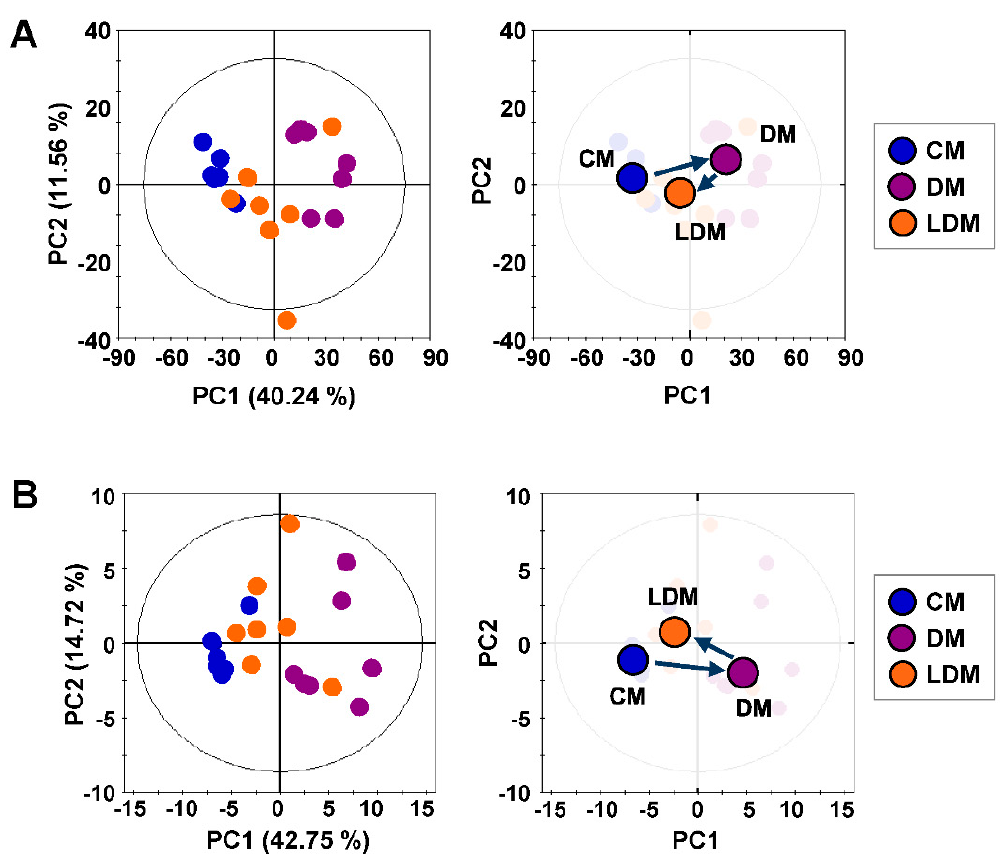
Figure 1. PCA score plots of metabolic profiles of mouse urine. The PCA score plot and trajectory analysis of the PCA score plot ( A ) of global metabolic profiles show perturbation of metabolic patterns in CM (blue dots, n = 6), DM (violet dots, n = 7), and LDM (orange dots, n = 7). The PCA score plot and trajectory analysis of the PCA score plot ( B ) of targeted metabolic profiles were similar to the global metabolic profiles. Circles represent medians of each group. PCA, principal component analysis; CM, control mice; DM, STZ-induced diabetic mice; LDM, losartan-treated diabetic mice. For the targeted metabolite analysis among CM, DM, and LDM, we identified 68 urinary metabolites in the NMR spectra. The PCA score plot of the metabolite concentrations showed good separation between CM and DM (R 2 = 0.762 and Q 2 = 0.421) (Figure 1B). Similar to the global profiling result, the metabolic pattern of LDM was directed toward that of CM. Partial least squares discriminant analysis (PLS-DA) of the quantified data was performed to observe di ff erences in metabolic patterns among the three experimental groups. The PLS-DA score plots showed a clear separation among the three groups (R 2 = 0.739 and Q 2 = 0.594) (Figure 2A). The validity of the PLS-DA model was confirmed by analysis of variance of the cross-validated residuals − 5 (CV-ANOVA) ( p = 2.95 × 10 ) and permutation tests (Figure 2B). The variable importance in projection (VIP) scores of the PLS model were used to find the metabolites with significant di ff erences among CM, DM, and LDM from 67 urinary metabolites (excluding creatinine from the 68 identified metabolites). The 45 metabolites with high VIP scores ( > 0.9) were considered to be important metabolites representing the di ff erence among the three groups (Figure